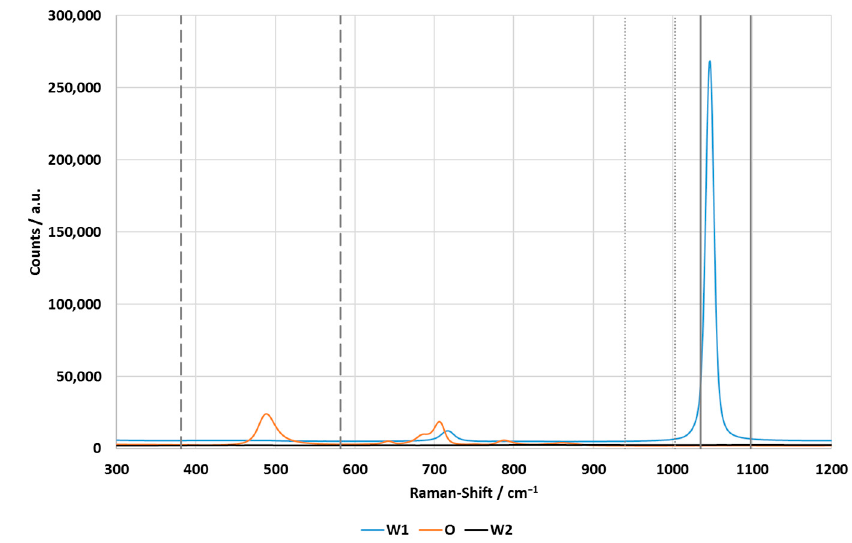
Figure 2. Spectra of the individually measured phases of the double emulsion. The spectra were measured using the Kaiser spectrometer at 1 s integration time and with five accumulations. The vertical lines visualize the limits of the oil phase filter (dashed lines), reference filter (dotted lines) and inner water phase filter (solid lines). Table 1. Summary of detected Raman bands, including the respective excited molecular